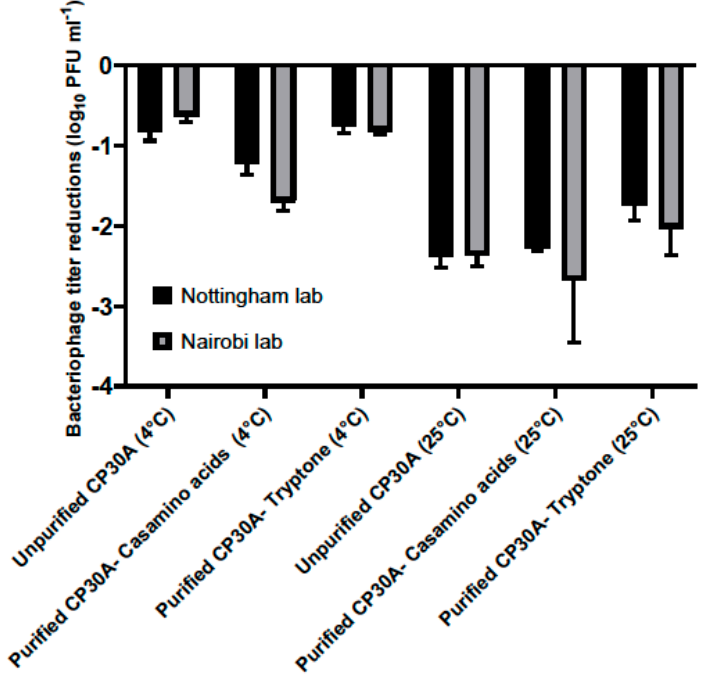
Figure 4. Titer loss of lyophilized phage CP30A after international transportation. Two identical sets of phage samples were aliquoted from the same stock. After lyophilization, one set was shipped to Kenya with and without temperature control and a second set was incubated in Nottingham lab to simulate the transport temperatures as a control set. Error bars represent the standard deviation of the mean between three biological